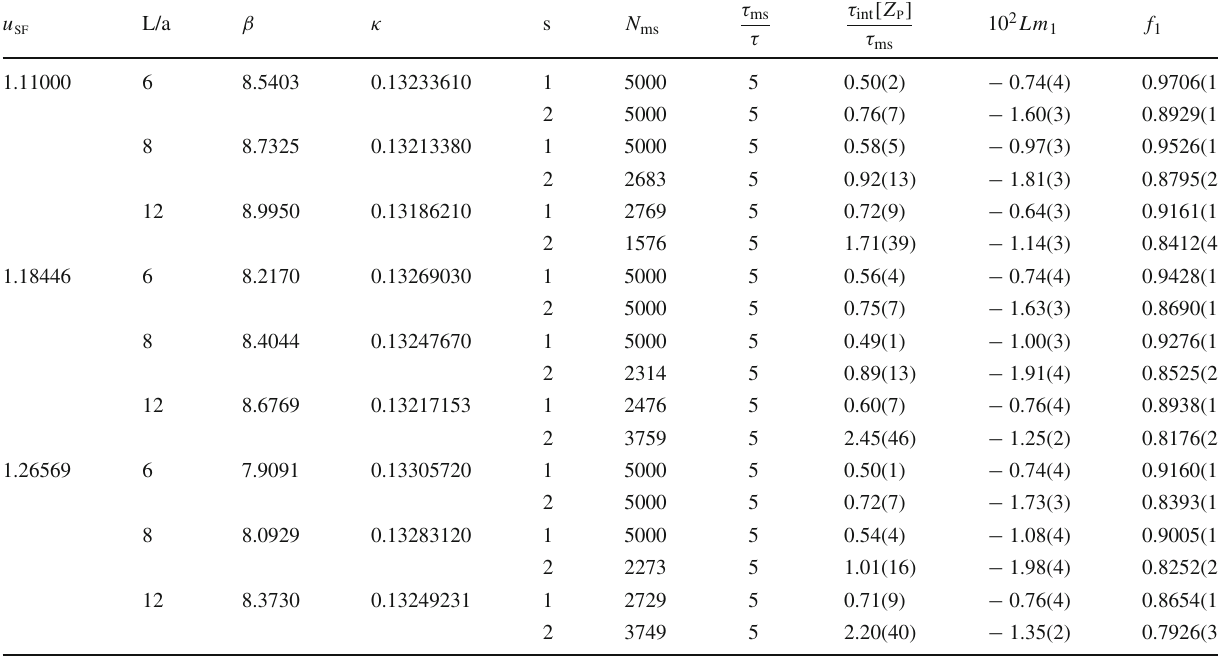
Table 9 Details for SF simulations of ( s × L / a ) 4 lattices with vanishing background field and plaquette gauge action, cf. Sect. 3. Each trajectory has a length of τ = 2 MD units, and lines of constant physics (fixed u SF ) are set with background field as reported in Refs.